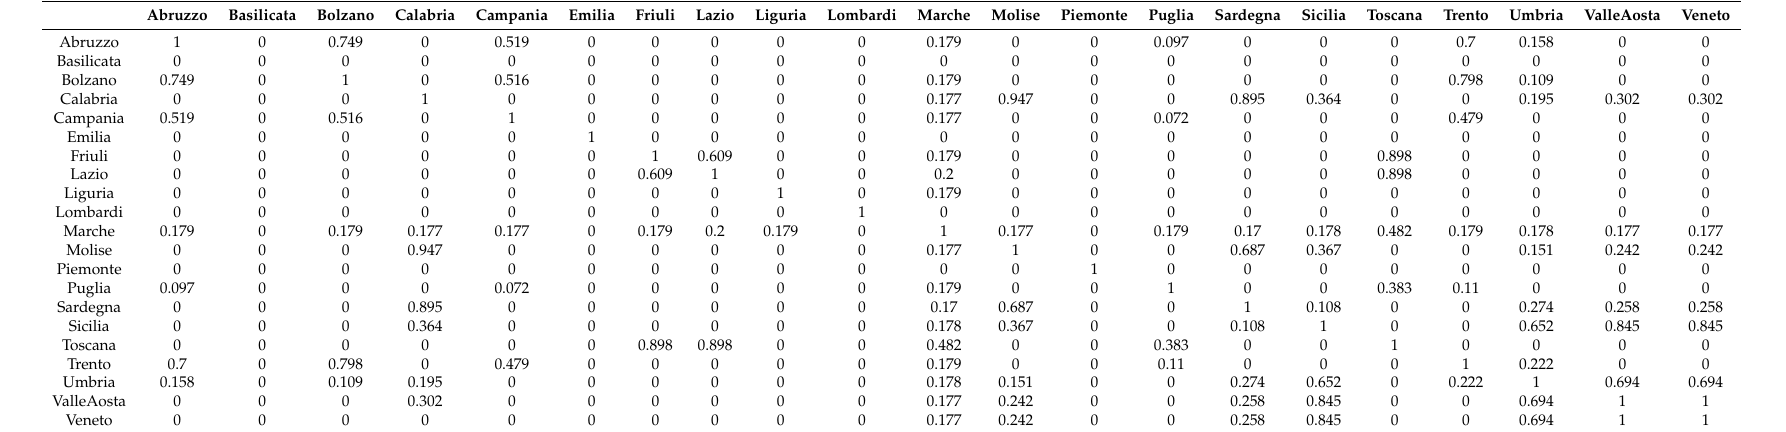
Table A47. Similarity values of Deceased network in the fourth week.